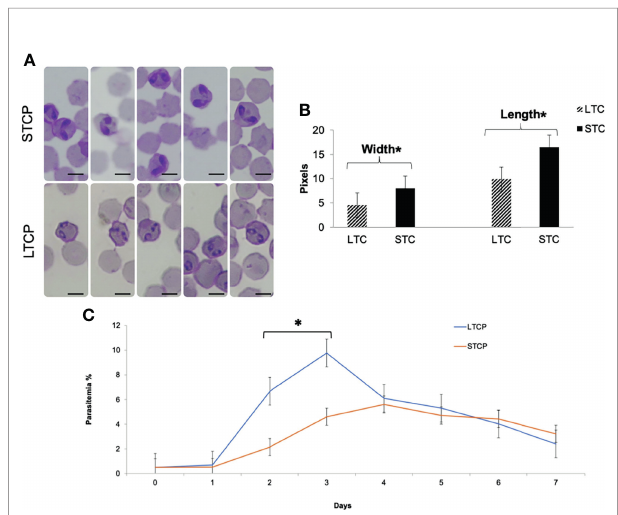
FIGURE 1 | Phenotypic differences among B. bovis LTCP and STCP. (A) morphological differences of LTCP vs STCP detected by light microscopy. Bar: 5 µm. (B) The average length and width were calculated as pixels from the images taken by light microscopy and is represented in the “ y ” axis. (*) Indicates signi fi cant differences in average parasite length and width between LTCP and STCP. (C) In vitro growth curve comparison of LTCP and STCP B. bovis strains. (*) Indicates signi fi cant differences in the growth rate in the 2nd and 3rd day of the